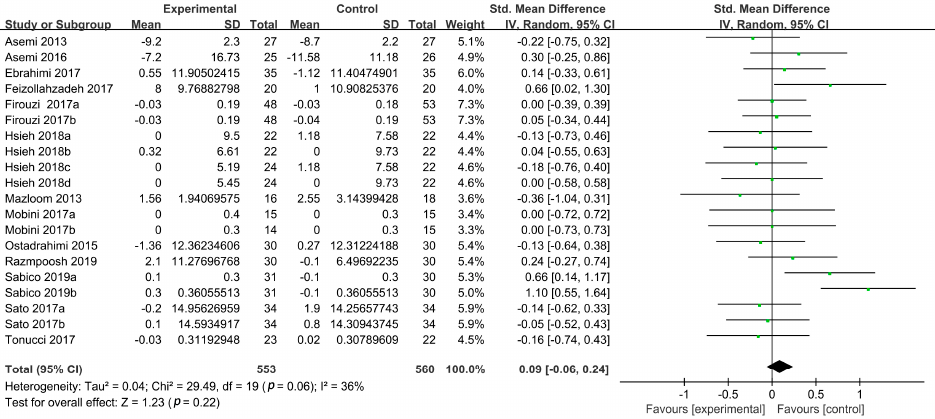
Figure 6. Forest plot of the effects of probiotics on HDL-C concentrations.